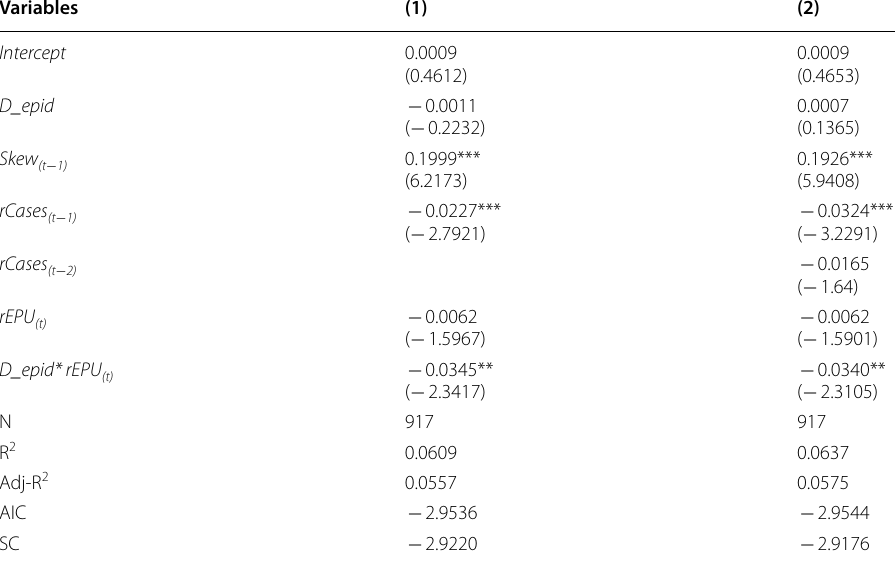
*** , **, * represent statistical significance at 1%, 5%, and 10% levels, respectively. The t‑statistics are presented in the brackets. We set the lag length of each variable based on the previous results in Table 6